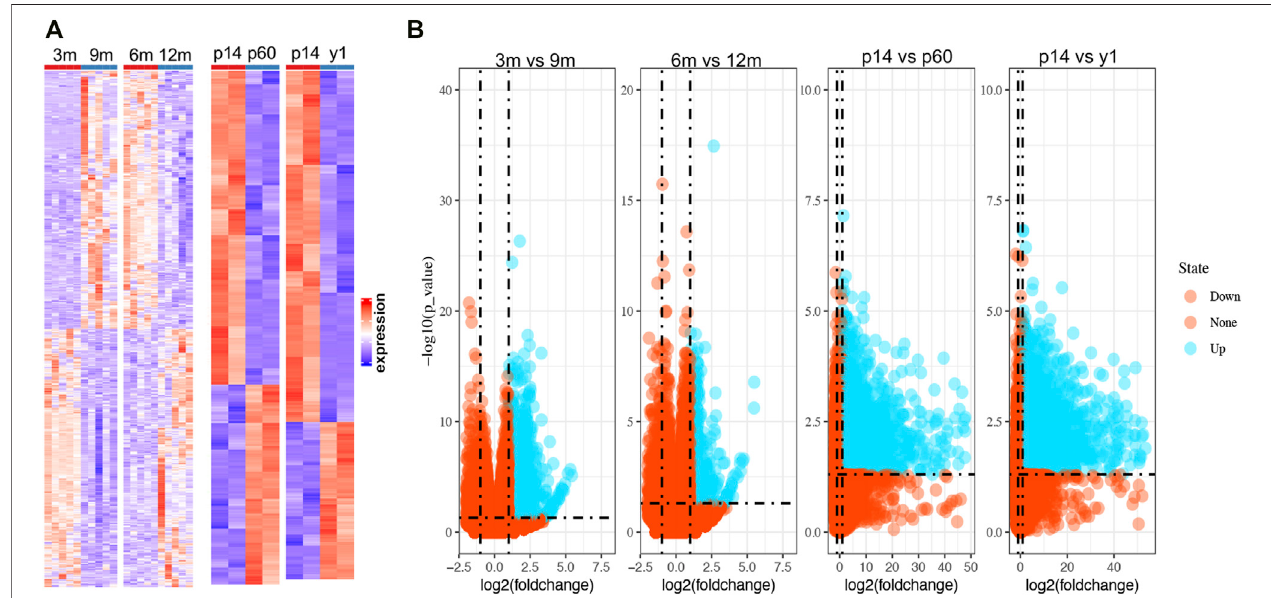
FIGURE2| TheheatmapsandvolcanoplotsofDEGsinmultipleORcomparisongroups. (A) HeatmapsforDEGsinfourORcomparisongroupsfromGSE154890 and GSE179888. Thered shadingrepresentstheupregulatedgenes,whiletheredshadingrepresentsthedown-regulatedgenes. (B) VolcanoplotsforDEGs.Theblue points representtheupregulatedgenes,and thered points representthenon-upregulated genesin highOR.DEGs werescreenedon thecriterion oflog2|FC| > 1.0and p < 0.05.